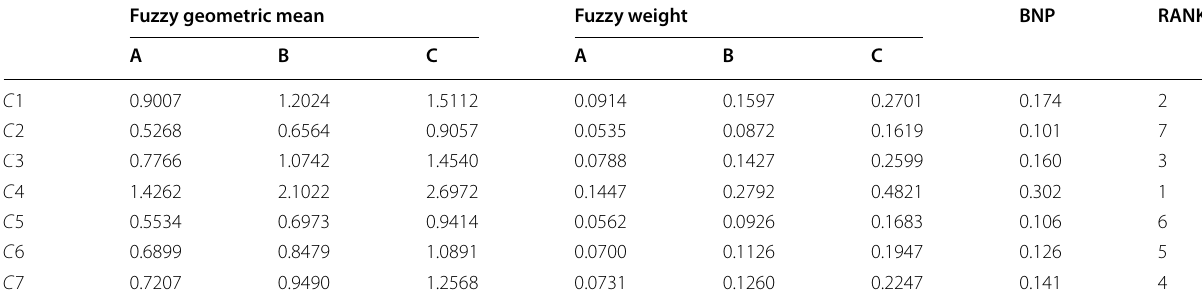
Table 7 The weight of criteria rating